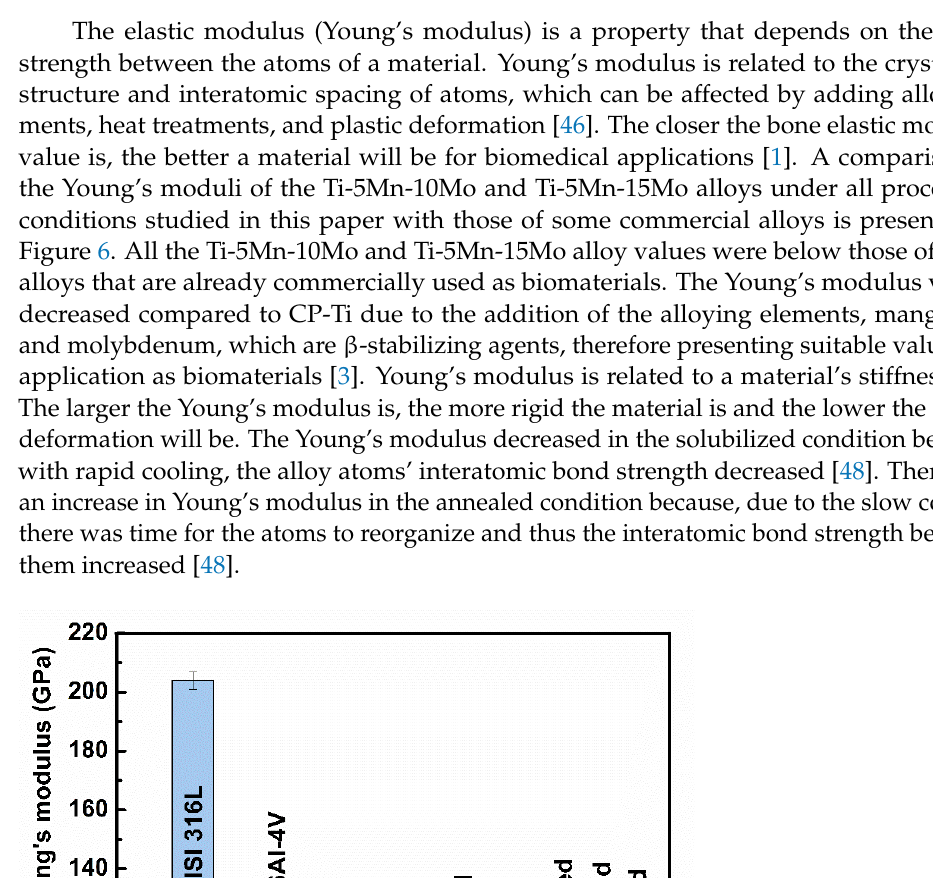
Figure 6. Comparison of Young’s modulus of the Ti-5Mn-10Mo and Ti-5Mn-15Mo alloys with com- mercial alloys under all processing conditions.